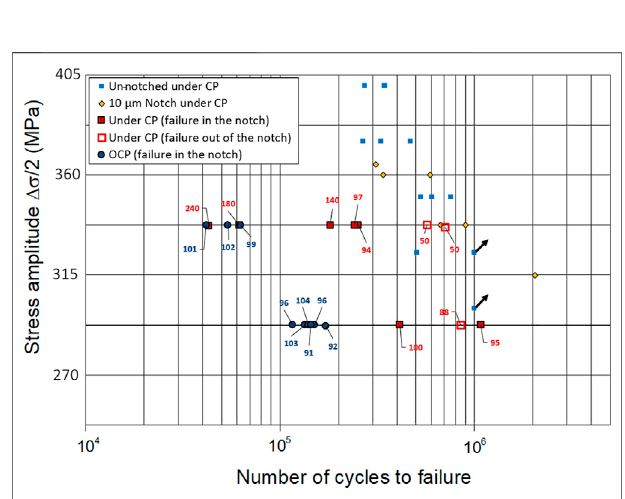
FIGURE10| ImpactofnotchdepthonthefatiguelifeofSDSS2samples tested in seawater at OCP and under CP. The notch depth in micrometer is indicated for each sample (in blue for OCP and red for